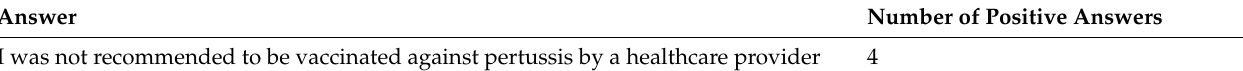
Table 5. Reasons not to be vaccinated against pertussis—4 patients who did not receive Tdap after being administered flu